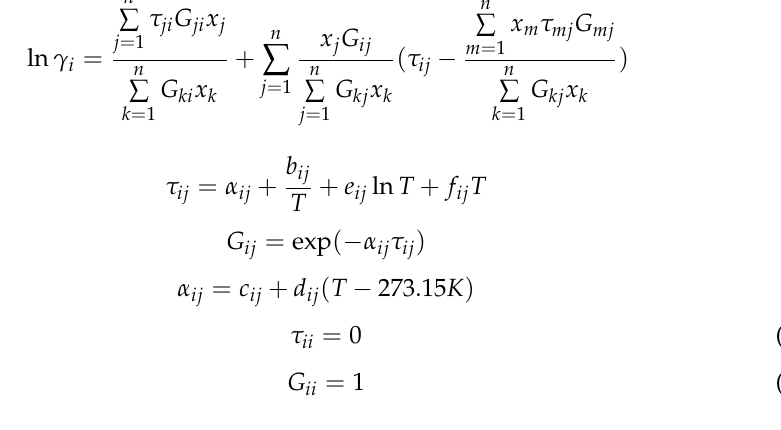
Figure 7. Equilibrium constant versus temperature.